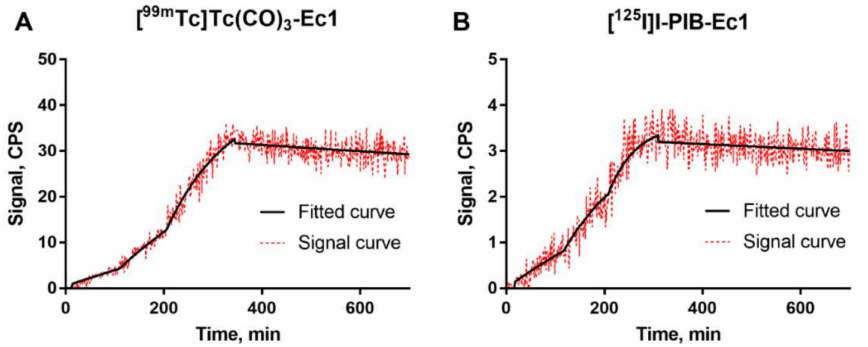
Figure 2. LigandTracer sensorgrams of [ 99m Tc]Tc(CO) 3 -Ec1 ( A ) and [ 125 I]I-PIB-Ec1 ( B ) binding to MDA-MB-468 cells. The association was measured at 0.2, 0.6, and 1.8 nM concentrations for [ 99m Tc]Tc(CO) 3 -Ec1 and at 1.8, 5.4, and 14.5 nM concentrations [ 125 I]I-PIB-Ec1.